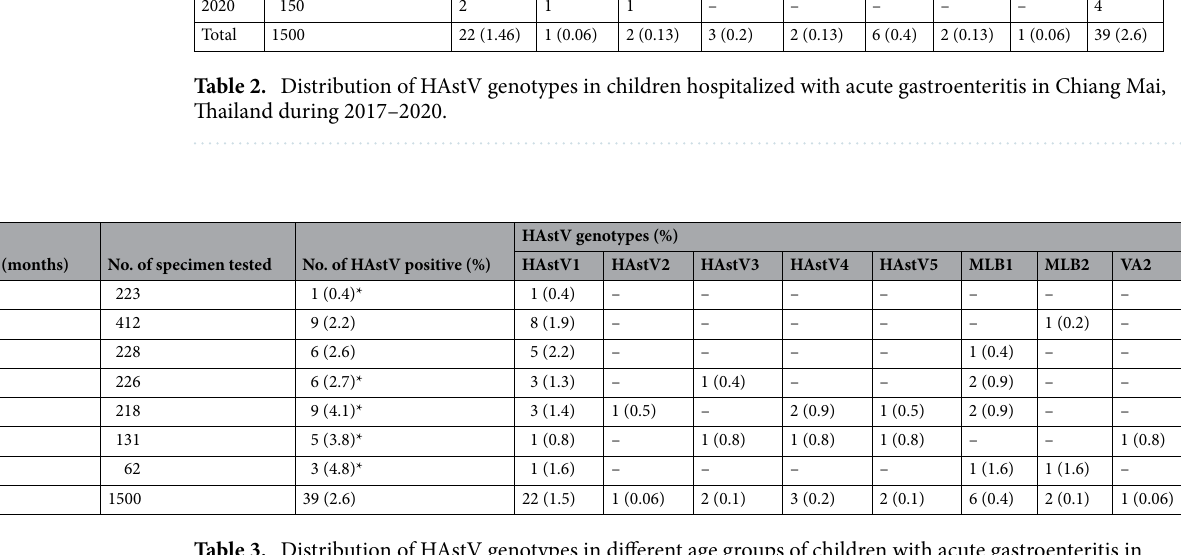
Table 3. Distribution of HAstV genotypes in different age groups of children with acute gastroenteritis in Chiang Mai, Thailand during 2017–2020. p value of < 1–6 vs > 18–24 = 0.049*; < 1–6 vs > 24–36 = 0.009*; <